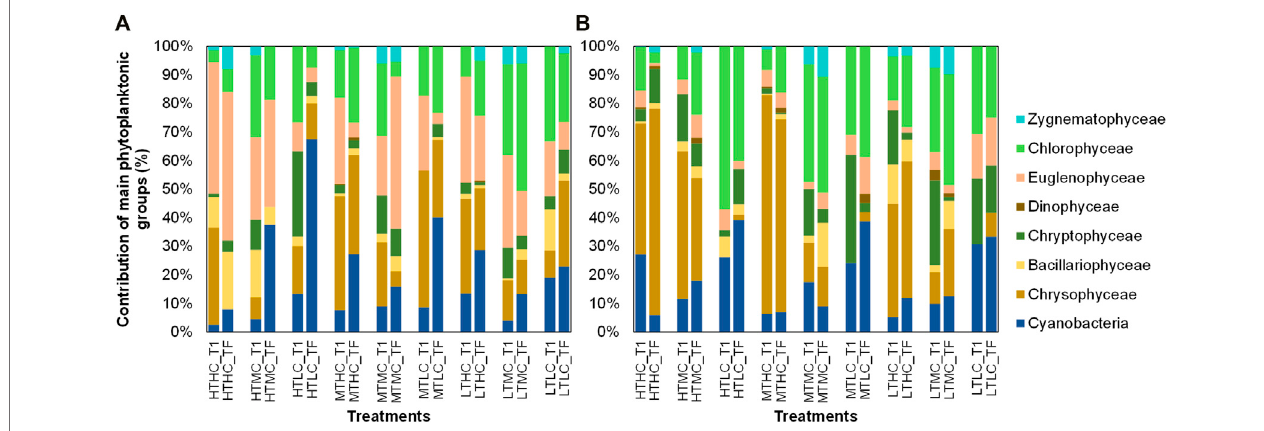
FIGURE 6 | Percent contribution (%) of main phytoplankton groups by sediment and by treatment at the initial time (T1) and fi nal time (TF). (A) , NB results; (B) , IB results. NB means Natural Batata and IB means Impacted Batata. HT: High Turbidity; MT: Medium Turbidity; LT: Low Turbidity; HC: High Chlorophyll; MC: Medium Chlorophyll; LC: Low Chlorophyll.